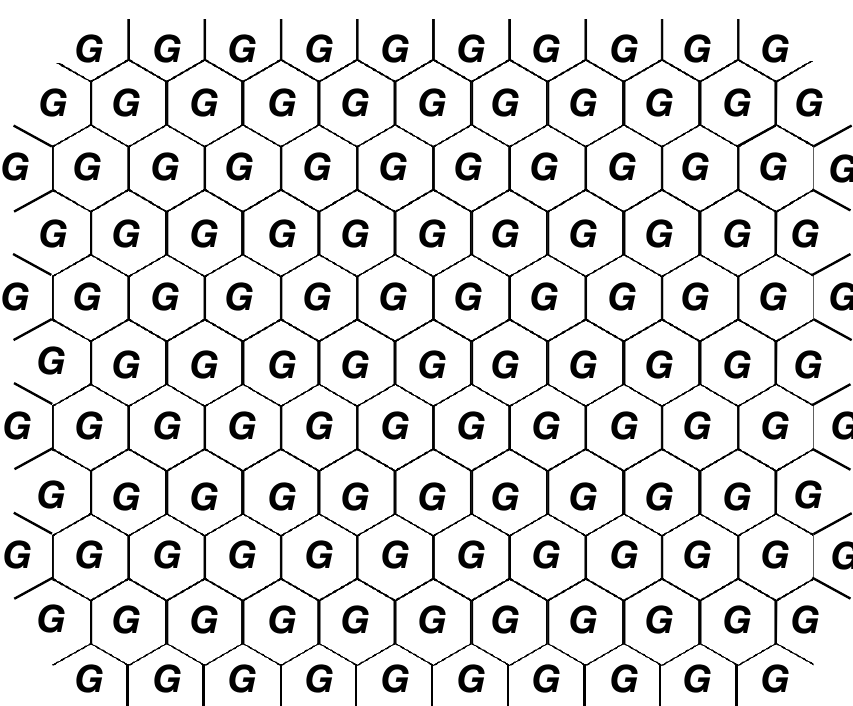
Figure 11 . Toric diagram for a threefold base B . Here, each compact face of the honeycomb represents a dP 3 surface. By suitable tuning of the elliptic (cid:12)ber, we can wrap 7-branes with gauge group G over each face of the